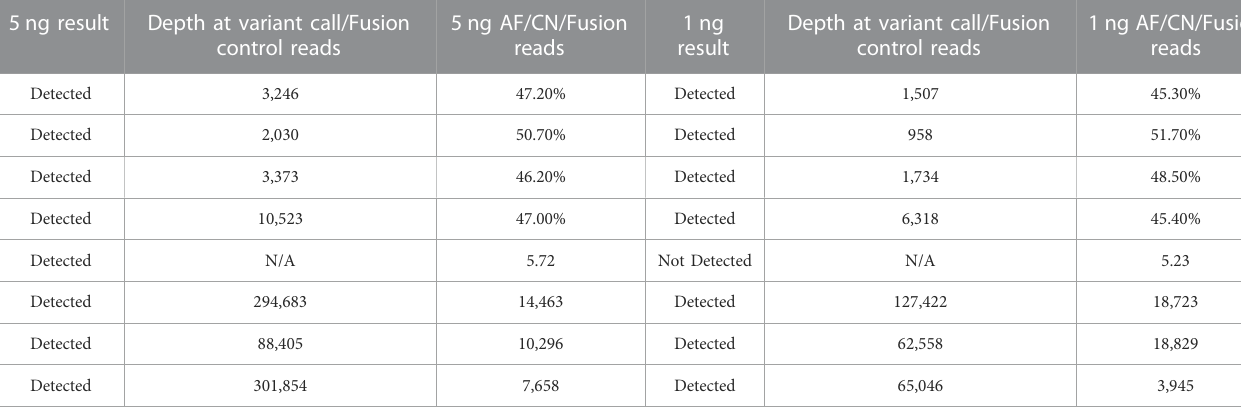
TABLE 9 Accuracy. The LOI of DNA and RNA. 5 ng result